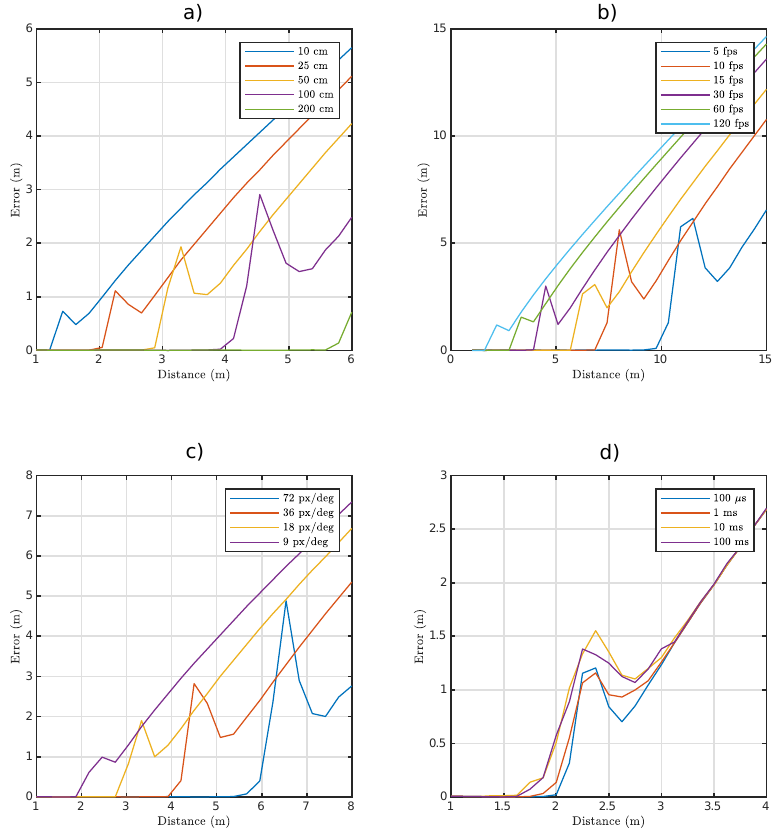
Figure 14. Effect of different parameters on error performance: object’s effective size ( a ); capture rate ( b ); FOV-to-resolution ratio ( c ); and guard time ( d ). All curves were obtained using the proposed mode-based filtering with 20